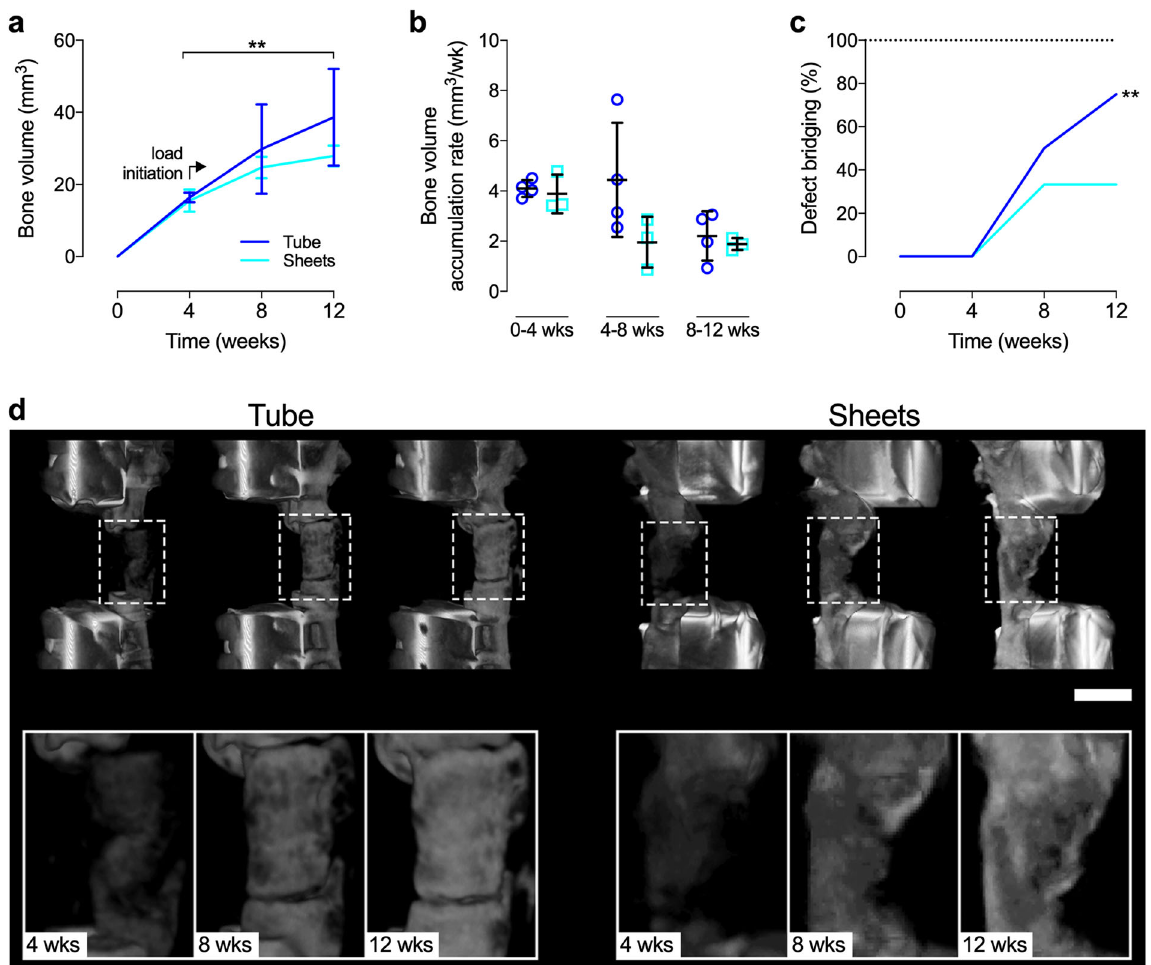
Fig. 6 In vivo microCT evaluation of femoral defect healing induced by engineered hMSC condensation tubes and sheets. Longitudinal morphometric analysis of a bone volume and b bone volume accumulation rate at weeks 4, 8, and 12 in defects implanted with hMSC tubes or sheets containing TGF- β 1 + BMP-2-loaded microparticles. Analyzed by two-way ANOVA with Tukey ’ s post hoc test ( p < 0.05 or lower considered signi fi cant). c Longitudinal determination of defect bridging, de fi ned as mineral fully traversing the defect ( n = 4 (tubes) or 3 (sheets) biologically independent samples per group; blue lines/circles = hMSC tubes; cyan lines/squares = hMSC sheets). Signi fi cance of trend analyzed by chi-square test (** p < 0.01). d Representative 3-D microCT defect reconstructions selected based on mean bone volume. Scale bar, 5 mm. Individual data points are shown with mean ±